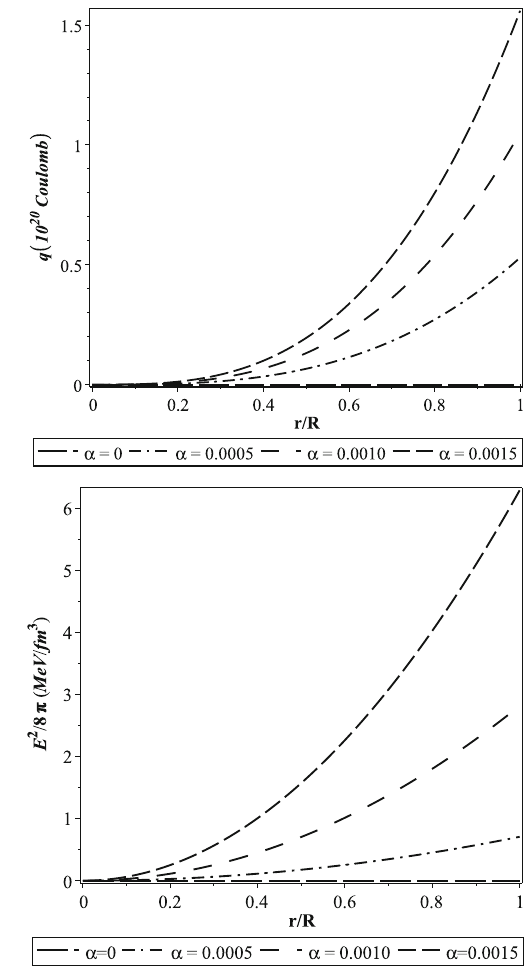
Fig. 3 anisotropy is zero at the center and maximum at the surface as predicted by Deb et al. [47].